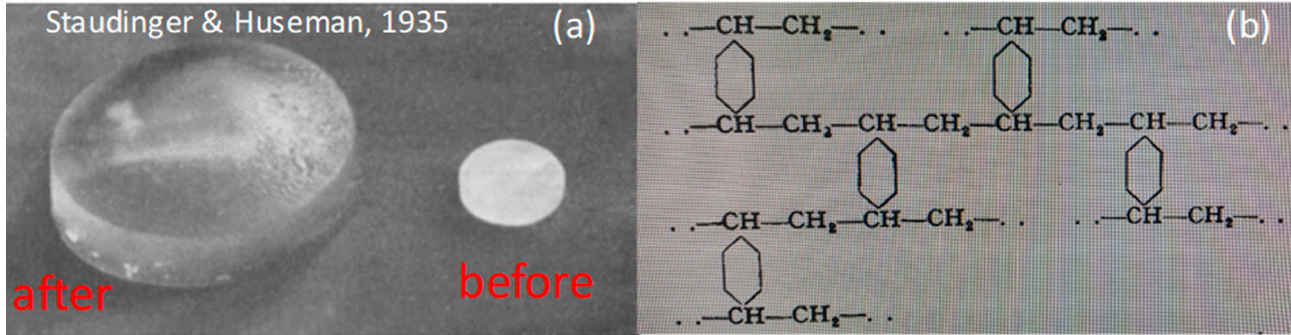
Figure 1. ( a ) Optical images of Staudinger’s organogels before and after swelling in benzene. ( b ) Chemical structure of cross-linked polystyrene proposed by Staudinger. From [3] with permission from Wiley-VCH Verlag GmbH & Co.